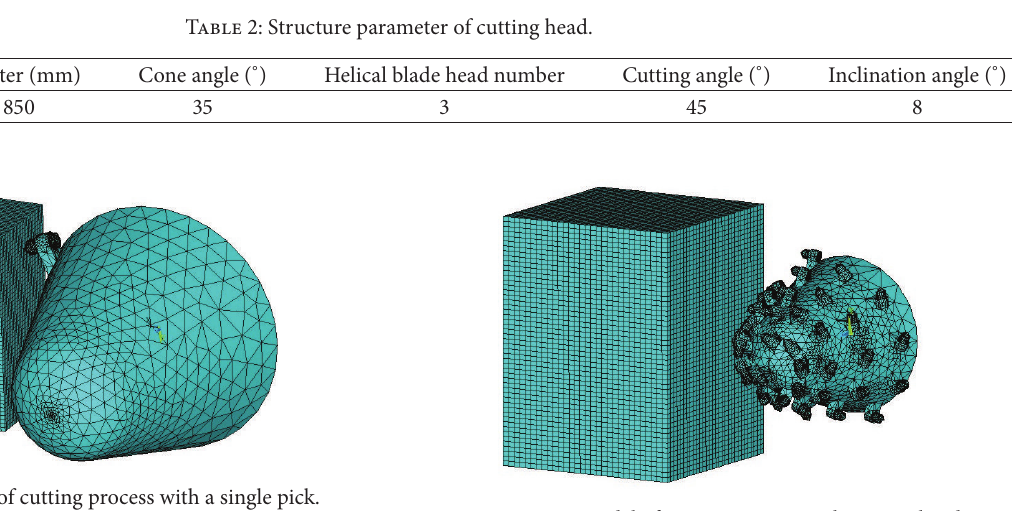
Figure 4: FE model of cutting process with cutting head.